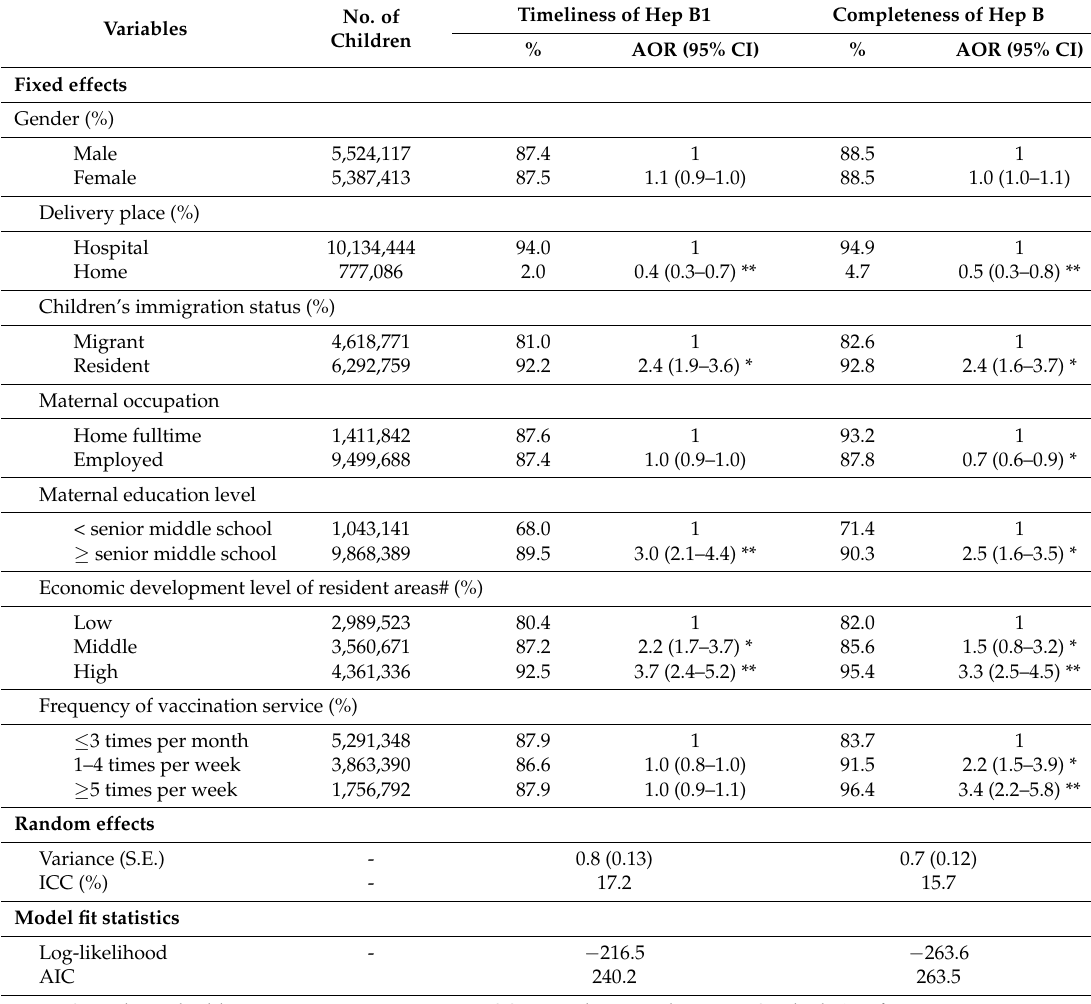
Table 3. Determinants associated with timeliness of Hep B1 and the completeness of Hep B for birth cohorts from 1999 to 2017, Zhejiang